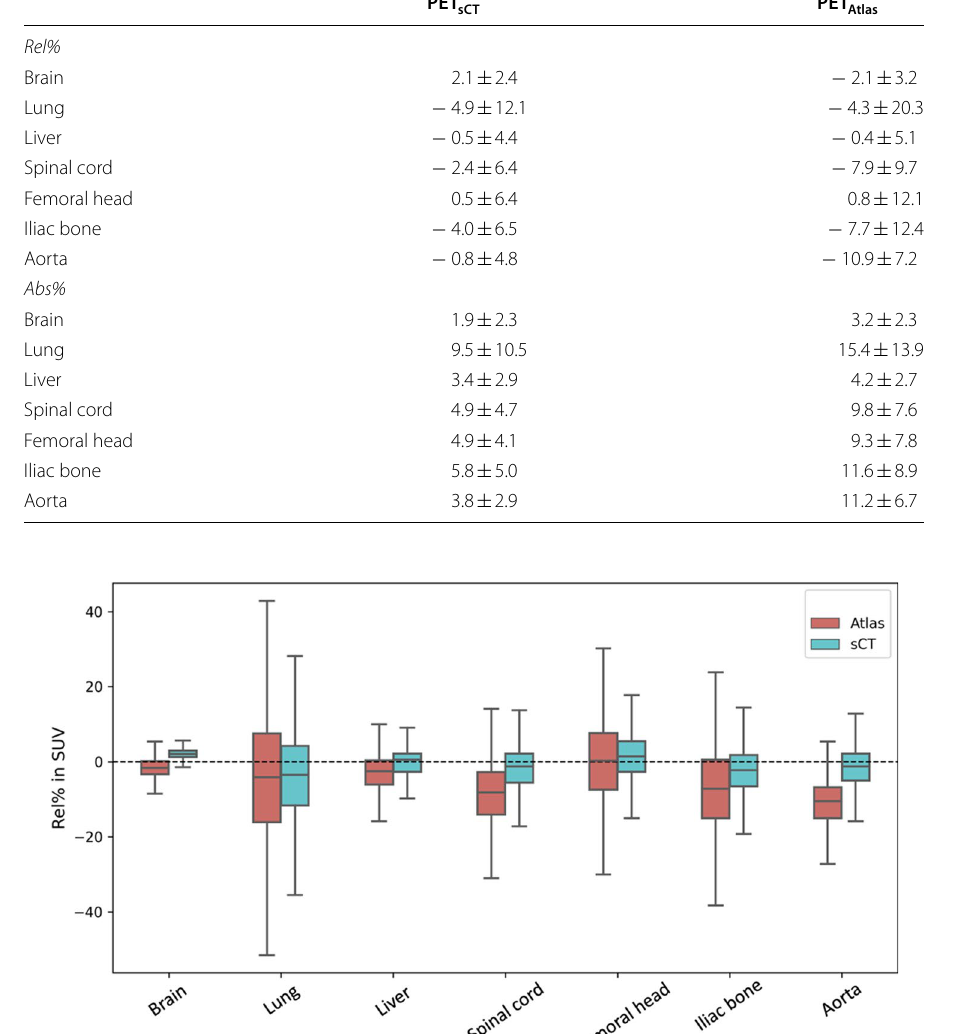
Table 1 Statistics for PET quantification errors of the two AC methods: the relative difference (Rel%) and absolute relative difference (Abs%) are reported for all the voxels within the specified regions PET sCT